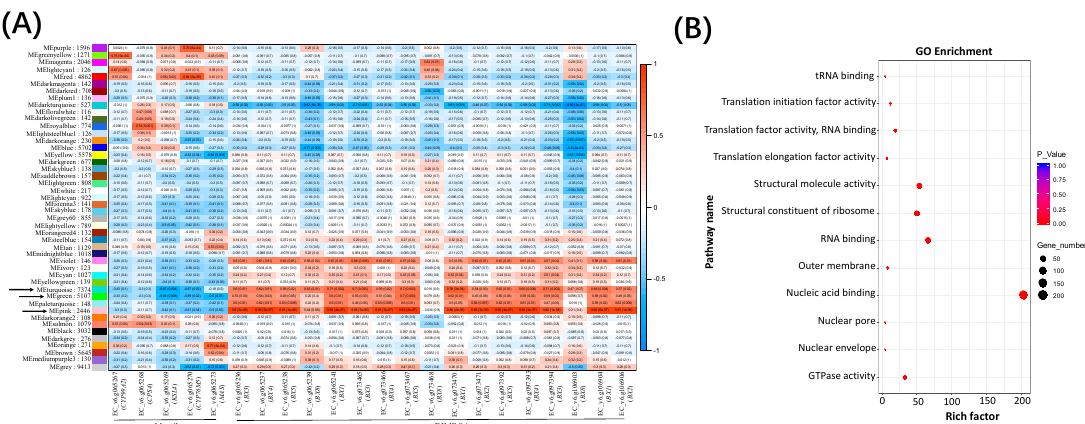
Figure 2. Co-regulated modules and hub genes with biosynthetic gene clusters in barnyardgrass. ( A ) The relationship between the 46 gene modules with genes in the three copies of the 2,4-dihydroxy-7-methoxy-1,4-benzoxazin-3-one (DIMBOA) gene cluster and the presumable momilactone gene clusters in barnyardgrass. Each row corresponds to a module eigengene (correlation between a column and a trait). Each cell contains the corresponding correlation efficient and p -value. The arrows indicate three highly co-expressed modules ‘MEpink’, ‘MEturquiise’ and ‘MEgreen’. ( B ) Gene Ontology (GO) enrichment result for the genes in the ‘MEpink’ module.